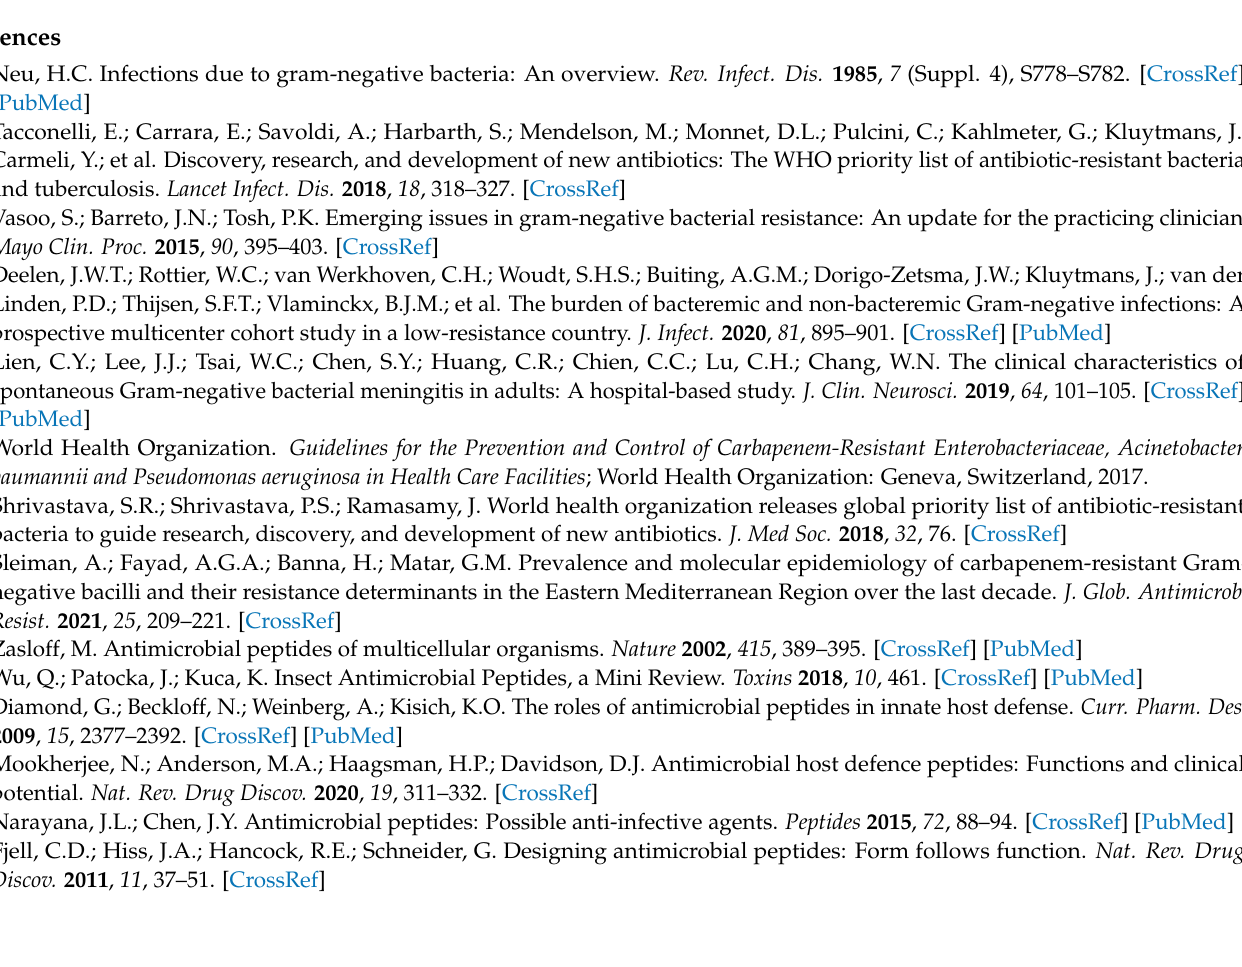
showing fractional inhibitory concentration index (FICI) calculated against CRAB C1 according to Equation (1), Figure S2: PapMA-3 and antibiotic checkboard assay results, showing FICI calculated against CRAB C2., Figure S3: PapMA-3 and antibiotic checkboard assay results, showing FICI calculated against CRAB C3, Figure S4: PapMA-3 and antibiotic checkboard assay results, showing FICI calculated against CRAB C4, Figure S5: PapMA-3 and antibiotic checkboard assay results, showing FICI calculated against CRAB